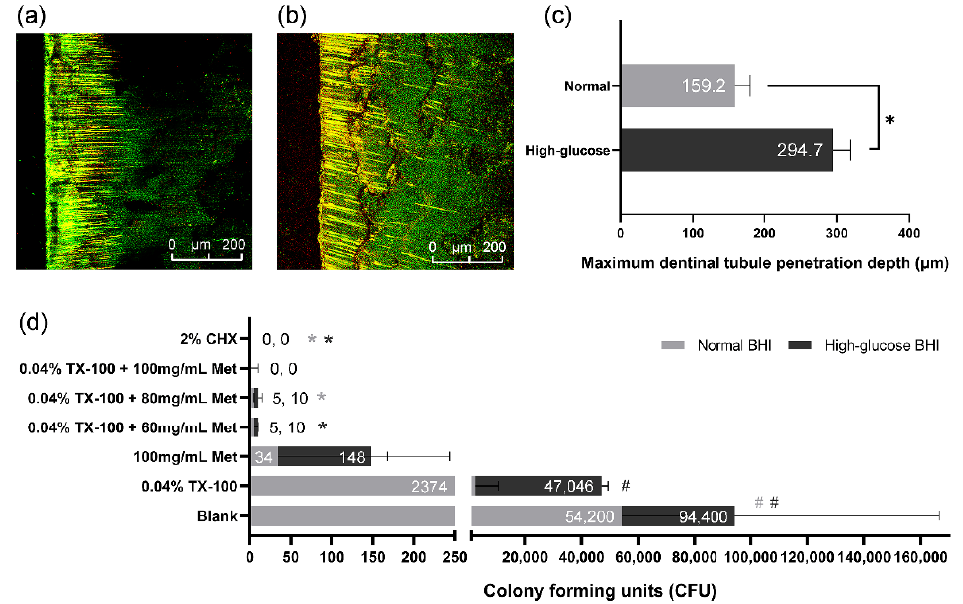
Figure 5. E. faecalis in dentinal tubules. ( a , b ) CLSM images (100×) of dentinal tubule invaded by E. faecalis in normal BHI and high-glucose BHI; ( c ) Mean tubule penetration depths of E. faecalis ; ( d ) CFU counting of E. faecalis in dentin powder samples. (*: significant difference compared with the blank control group; #: significant difference compared with the 2% CHX group; p < 0.05).